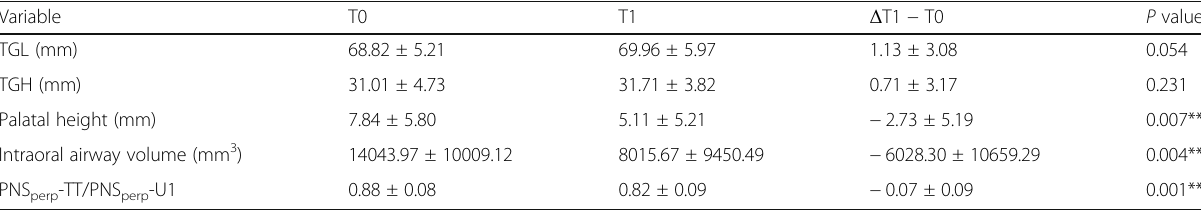
Data are presented as mean ± standard deviation. Paired t tests were performed to determine significant differences in tongue dimension and position between T0 and T1. T0 before surgery, T1 1month after surgery, TGL tongue length, TGH tongue height * P < 0.05; ** P < 0.01; *** P <